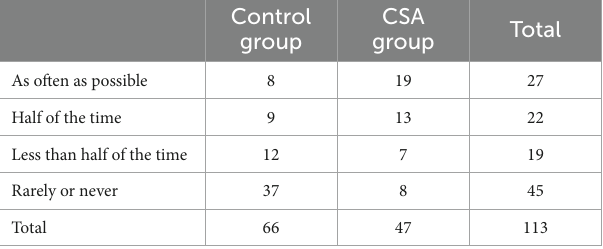
TABLE 4 Cross tabulation of frequency of purchasing organic food when grocery shopping (as often as possible, half of the time, less than half of the time, never) comparing CSA members and control group